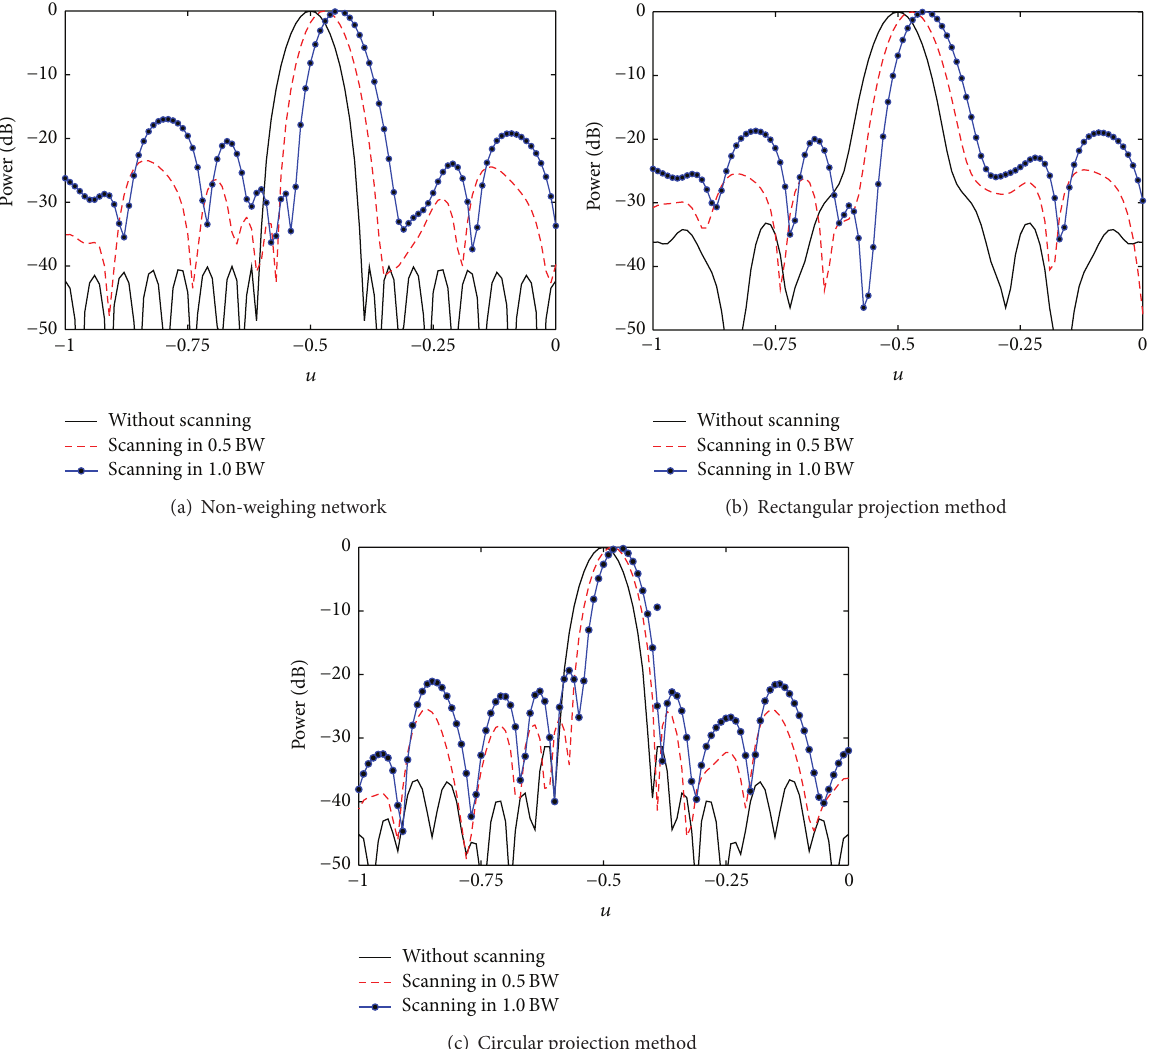
Figure 14: Array patterns with beam scanning obtained by ISP method (azimuth cut).